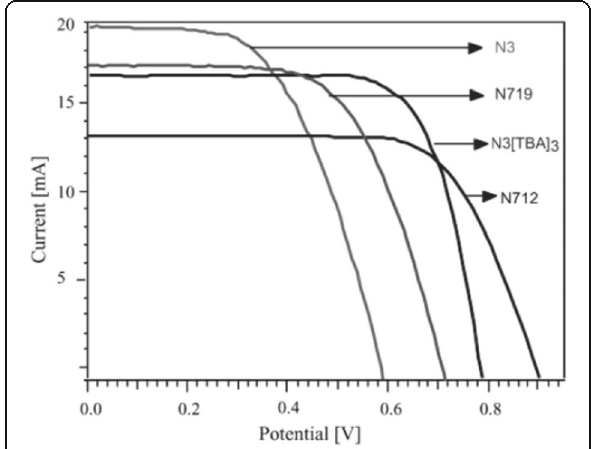
Fig. 14 Effect of dye protonation on photocurrent-voltage characteristics of nanocrystalline TiO 2 cell sensitized with N3 (4 protons), N719 (2 protons), N3[TBA] 3 (1 proton), and N712 (0 protons) dyes, measured under AM 1.5 sun using 1 cm 2 TiO 2 electrodes with an I − /I 3 − redox couple in methoxyacetonitrile